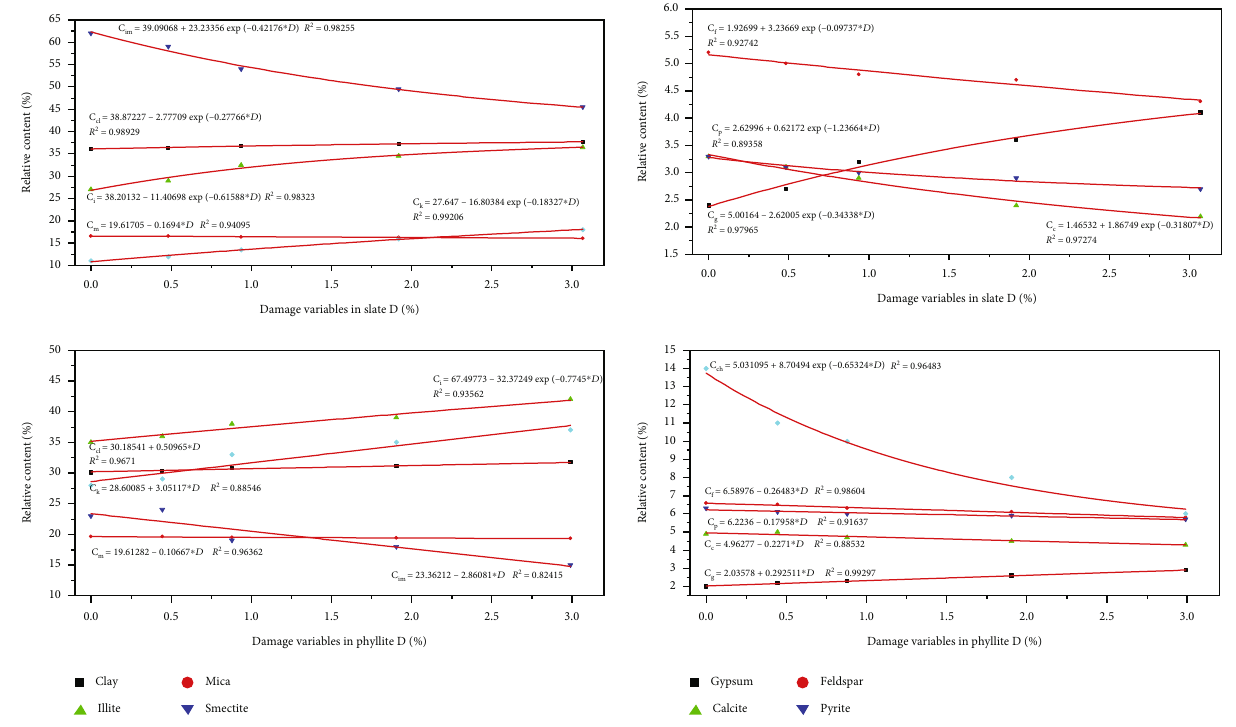
Figure 13: Relationship between mineral content of specimens and damage